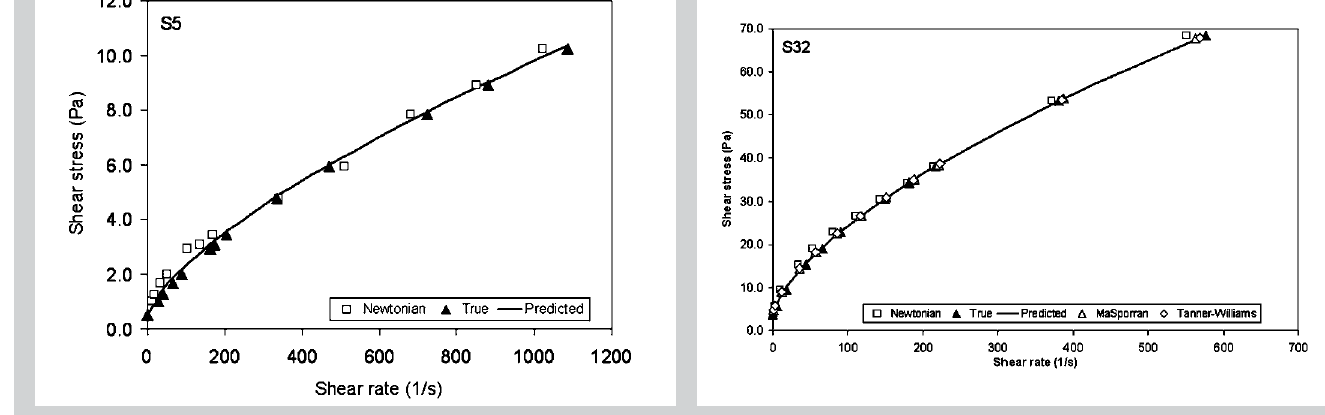
Figure 5 (left): Rheograms for sample S5 with Newtonian and true shear rates as well as the predicted shear stresses Figure 6: Comparison of three differ- ent solution methods (MacSporran [50], Tanner- Williams [52] and the new approach), for true shear rates, for the data of Krieger and Maron [24]. Computa- tion of Newtonian shear rates is also shown. The pre- dicted values by the new approach ('prediction') are also shown as the solid line (Data: 62.2% solids, r = 2.357 cm, r = 2.508 cm, 1 2 d =